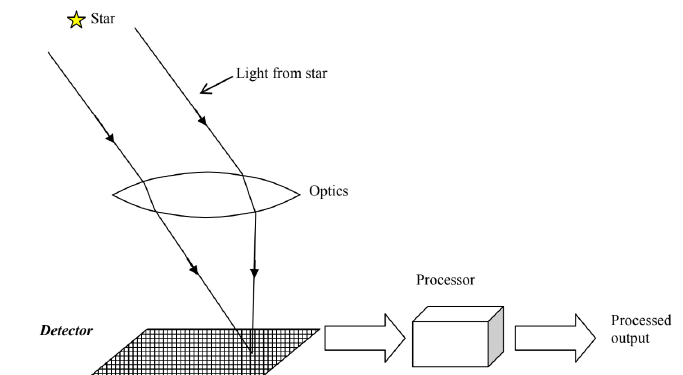
Figure 1. Schematic generalised star sensor model (reprinted from ECSS-E-ST-60-20C [22] with permission of the European Space Agency, the owner of the copyright on behalf of ECSS).